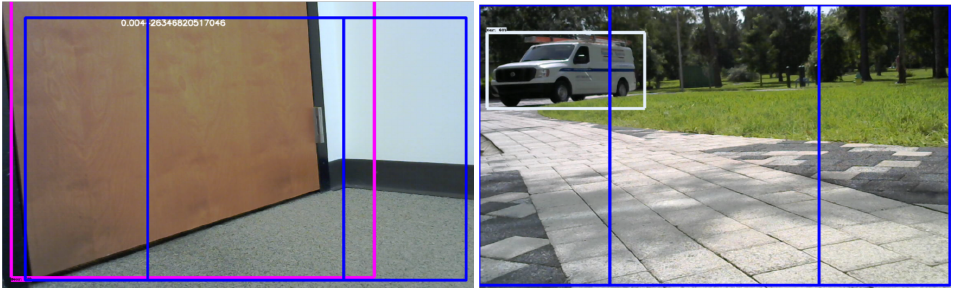
Figure 2. Object detection of door and car with